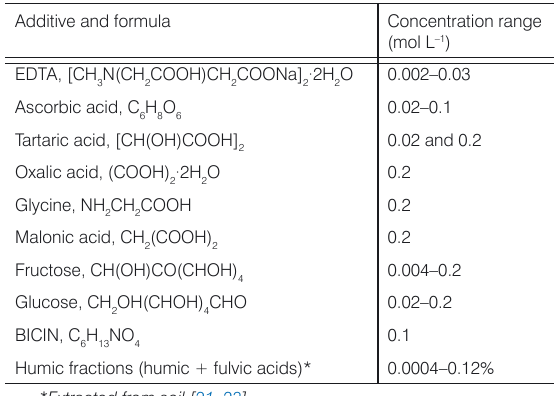
Table 2. Additives for preparation of arsenic solutions. Additive and formula